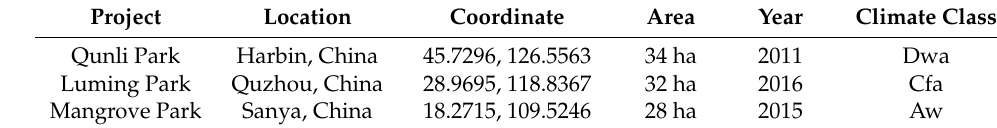
Table 1. Basic information about the study area.